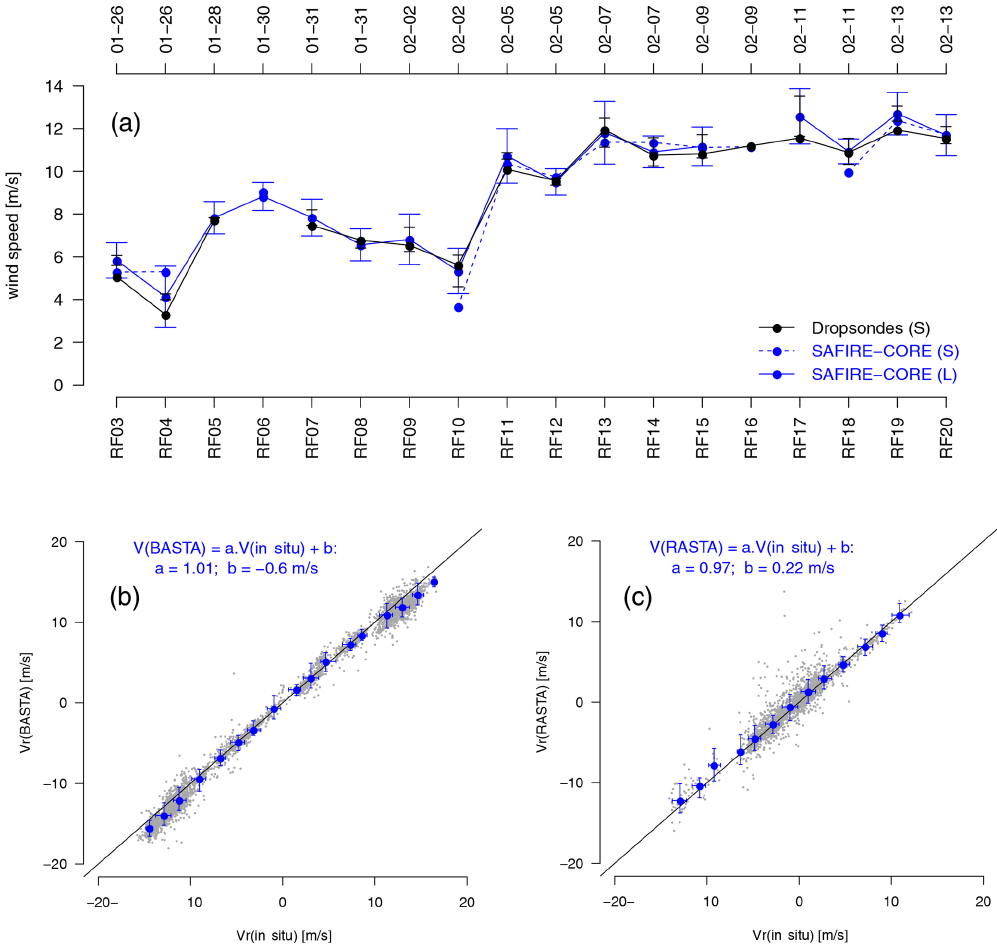
Figure 17. (a) Comparison of the wind speed measured by the core instrumentation of the ATR (SAFIRE-CORE) in the subcloud layer with the near-surface wind measurements (at 60m, close to the altitude of the near-surface legs of the ATR) from the HALO dropsondes. Each marker corresponds to the average value, for a given ATR flight, of the measurements collected over all the L patterns or S patterns of this flight, and the vertical bar represents the standard deviation among the different segments of a given pattern. Note that the time axis is not linear. (b, c) Comparison of the radial component of the wind (perpendicular to the aircraft) derived from the aircraft probes (SAFIRE-CORE dataset) with that inferred from (b) the horizontally staring BASTA Doppler radar at 25m from the aircraft or (c) the vertically pointing RASTA Doppler radar at 60m above the aircraft; the comparison is done for all R patterns flown at cloud base during the EUREC 4 A campaign (note that there were no wind measurements from RASTA from RF05 to RF12 and on RF20). Individual data points are shown in gray, and the binned relationship between the two measurements is shown in blue. Horizontal and vertical bars indicate the 25th–75th percentiles of the measurements within each bin of 2ms − 1